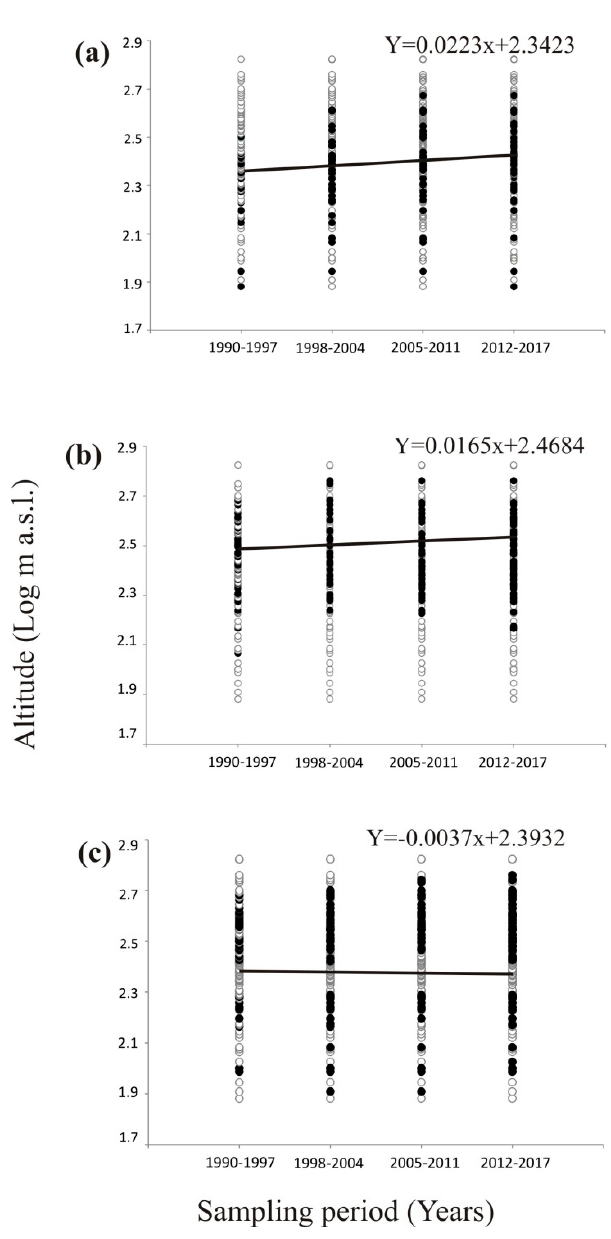
Figure 5. Occupancy-elevation plots showing occupied (filled circles) and unoccupied (clear circles) sites for each time period for: ( a ) Squalius lucumonis , ( b ) Telestes muticellus and ( c ) Padogobius nigricans. Solid lines represent the linear regressions.